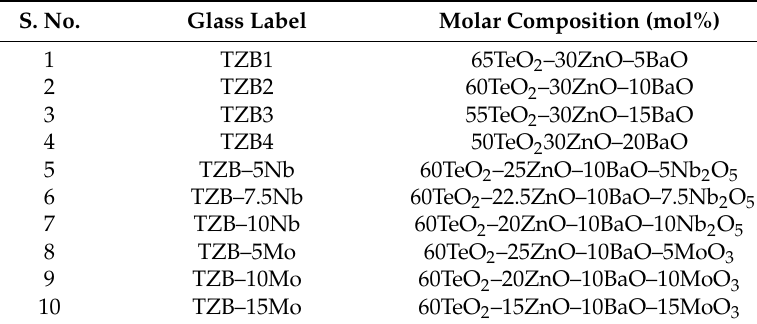
Table 1. Glass compositions and their labels of TeO 2 –ZnO–BaO glasses. S.